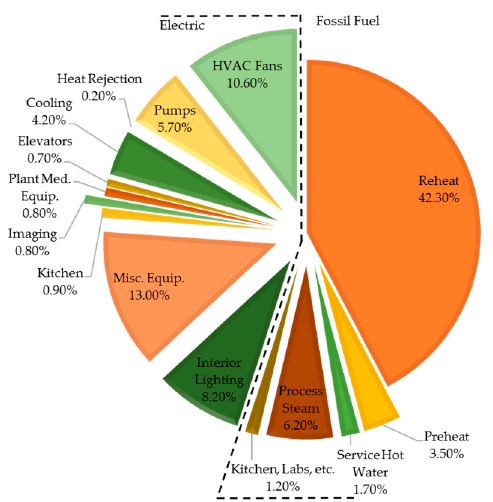
Figure 3. Breakdown of energy consumption in a U.S. hospital. Note: Reproduced with permission from [22].